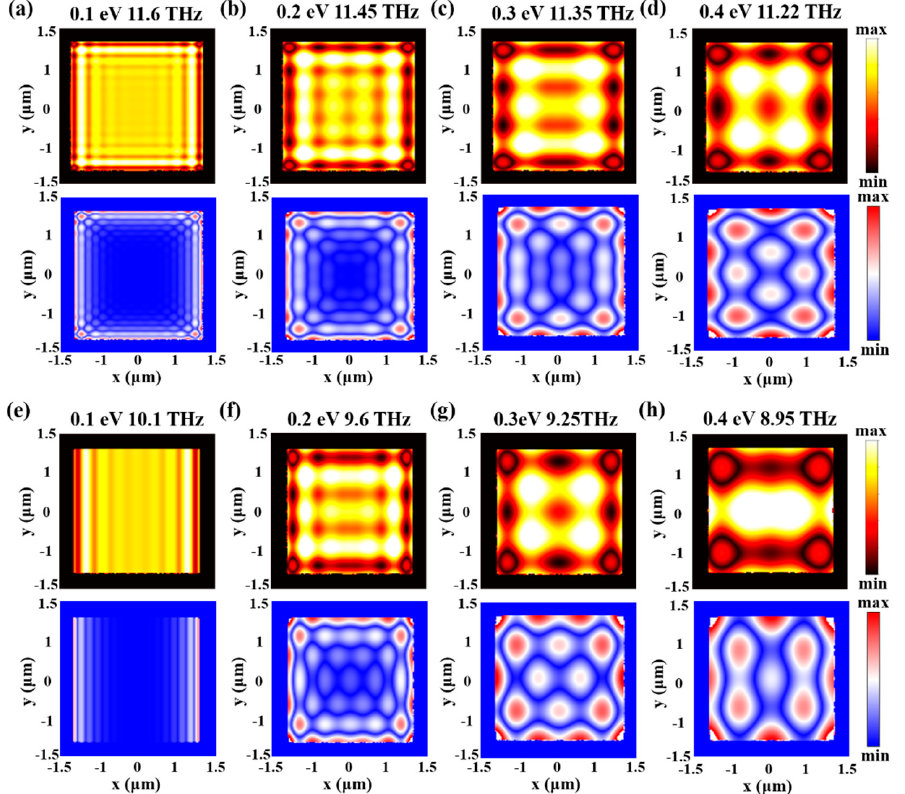
Figure 6. Near-field interference patterns of hybrid polaritons in graphene/ α -MoO 3 heterostructure micro-flakes. ( a – d ) The near-field amplitude interference patterns ( top panel ) and phase images ( bottom panel ) on top of the graphene/ α -MoO 3 micro-flakes at the high-frequency band. ( e – h ) The near-field amplitude and phase images on top of the graphene/ α -MoO 3 micro-flakes at the low frequency band.